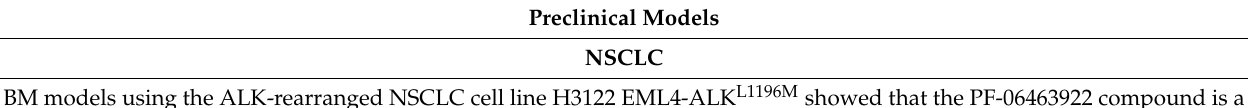
Table 1. Blood–brain barrier/blood–tumor barrier heterogeneity in preclinical and clinical